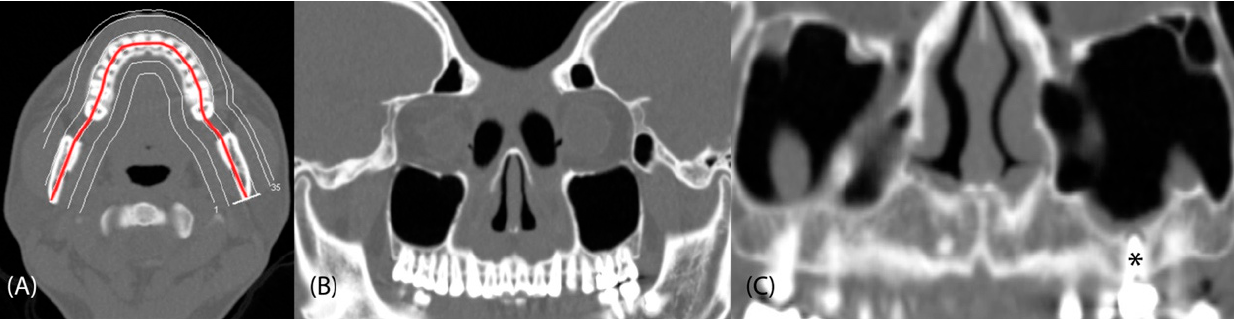
Figure 1. Continuous panoramic images of the maxillary teeth for detecting dental pathologies were yielded after CPR. ( A ) A series of CPRs were generated by drawing a reference line (red line) along the centerline corresponding to the maxillary teeth. Continuous CPR images were reconstructed according to lines parallel to the reference line. ( B ) A simulated dental panoramic image was created after reconstruction. ( C ) CPR detected a periapical abscess with a fistula in a left maxillary molar (no. 26, *).